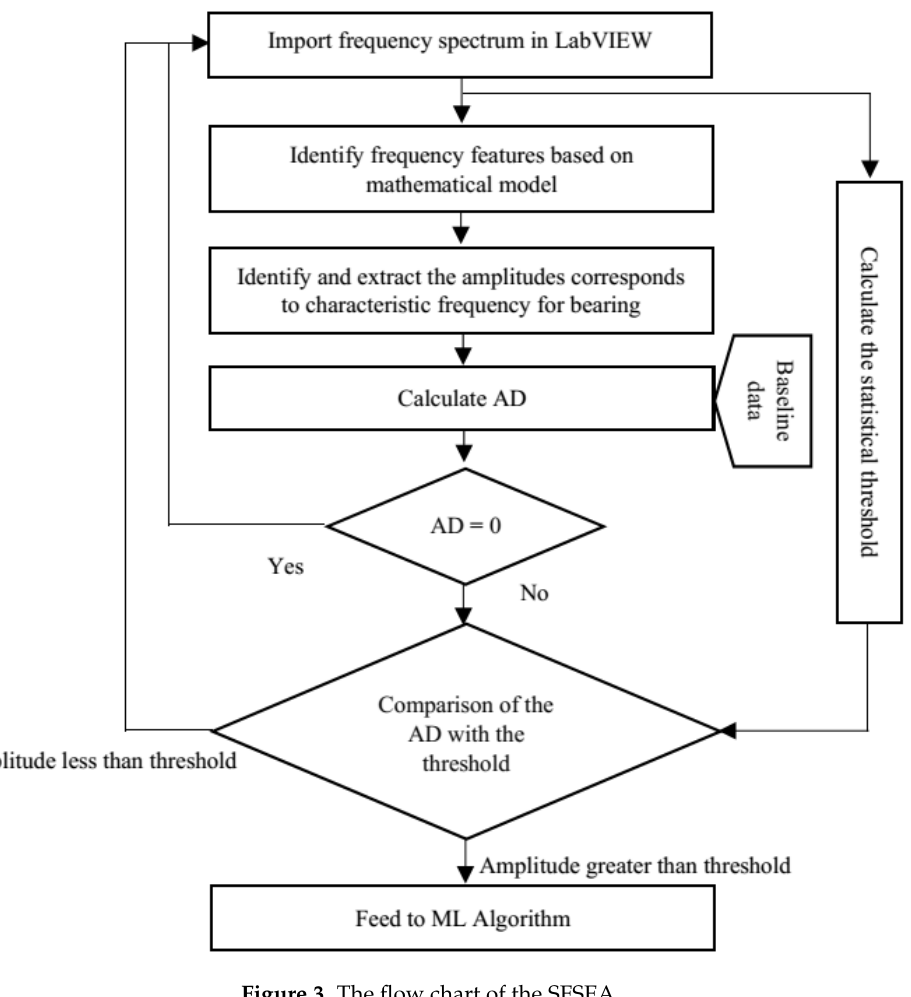
Figure 3. The flow chart of the SFSEA. Table 1. The location of fault features in the IPS under various shaft